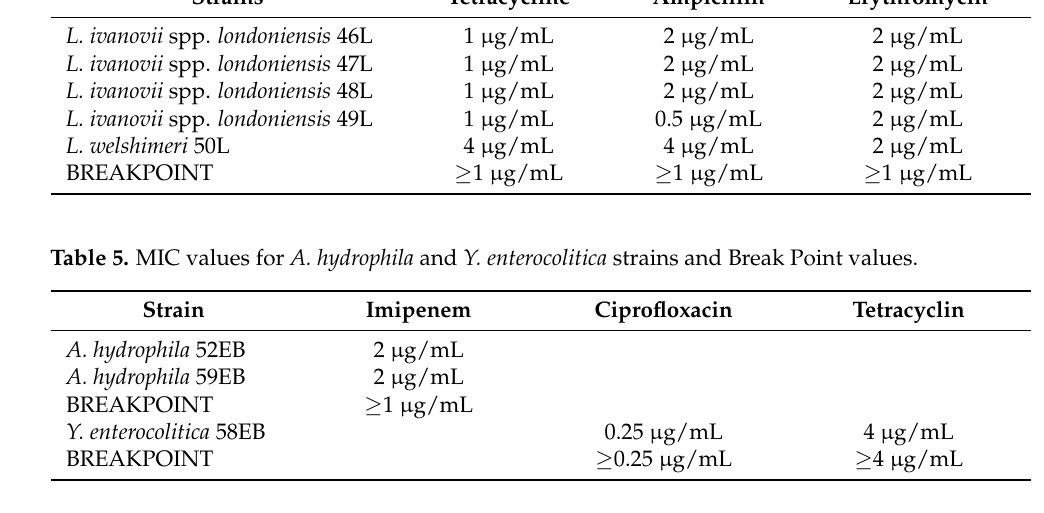
Table 4. MIC values for Listeria strains and Break Point values. Strains